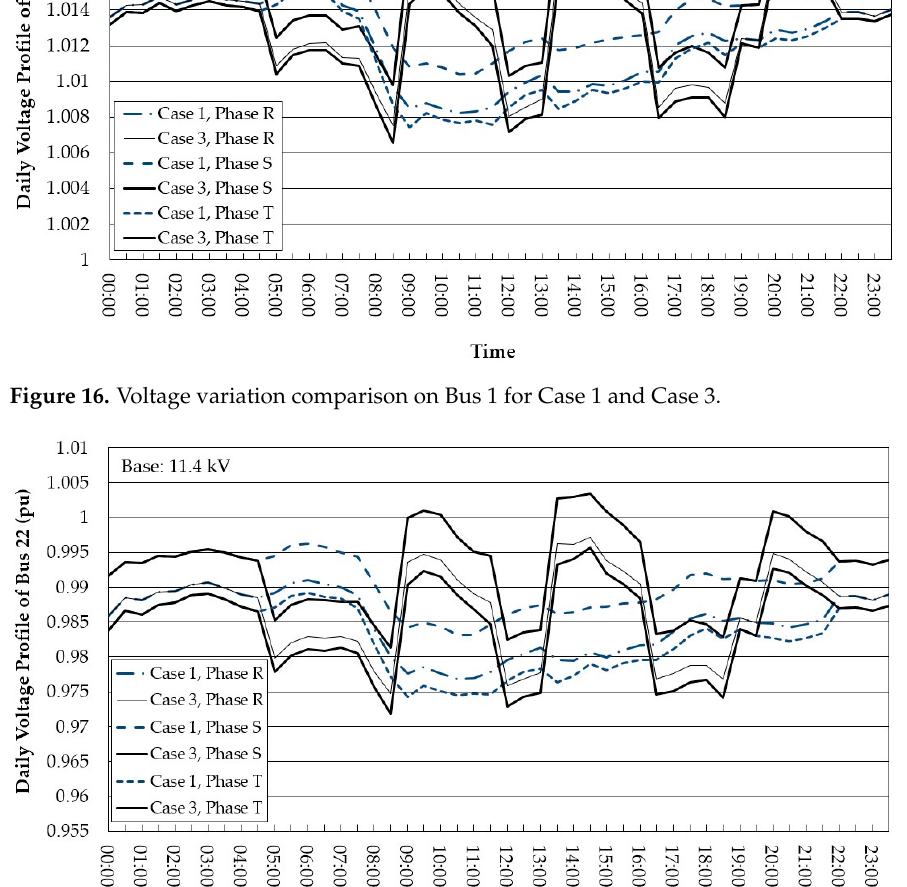
Figure 17. Voltage variation on Bus 22 for Case 1 and Case 3.